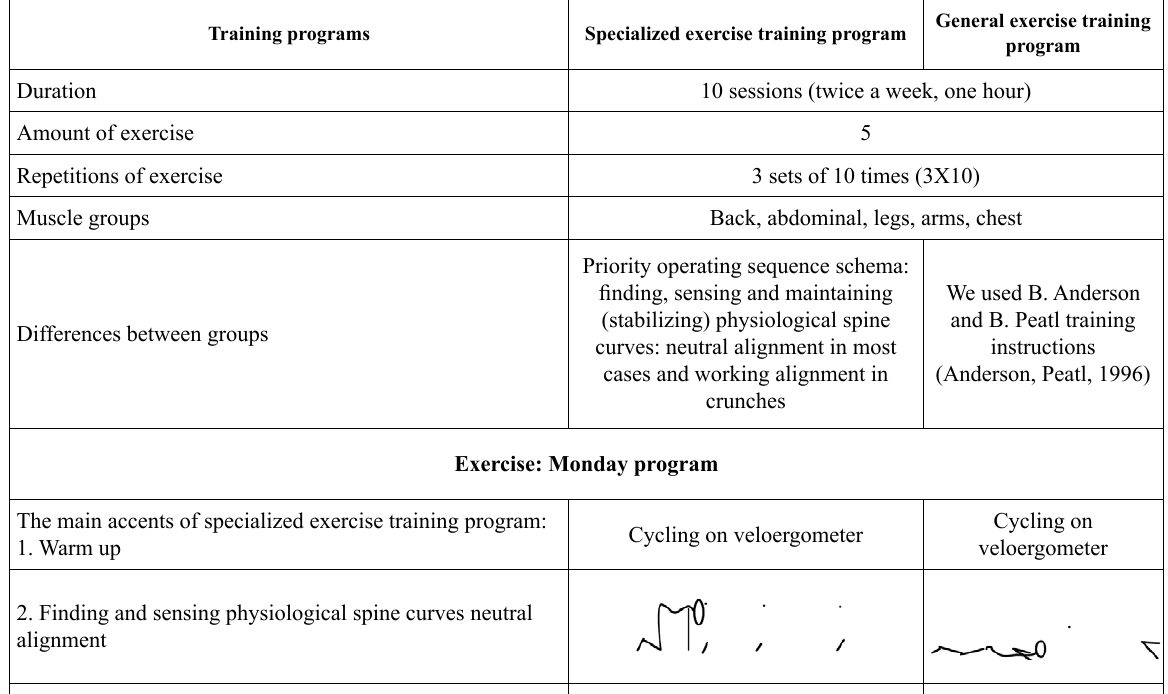
Table 2. Summary of specialized and general training